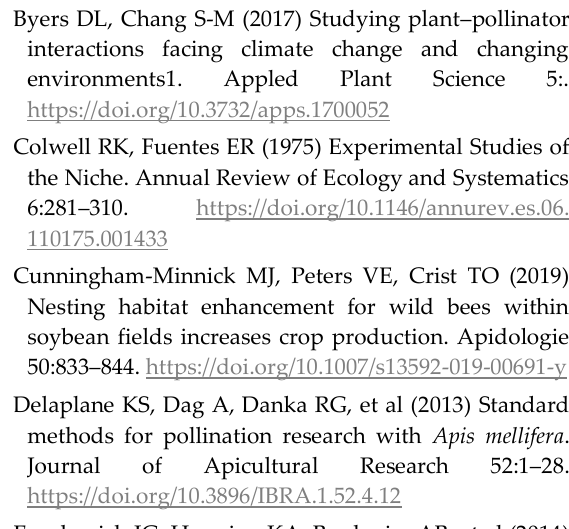
Figure 6. Fruit set per flower by plant species. See Fig. 5 for additional details on box and whisker plot components. Box plots with the same letter code indicate no significant difference in fruit set after controlling FWER using Tukey’s HSD. For further plot information see Fig 5